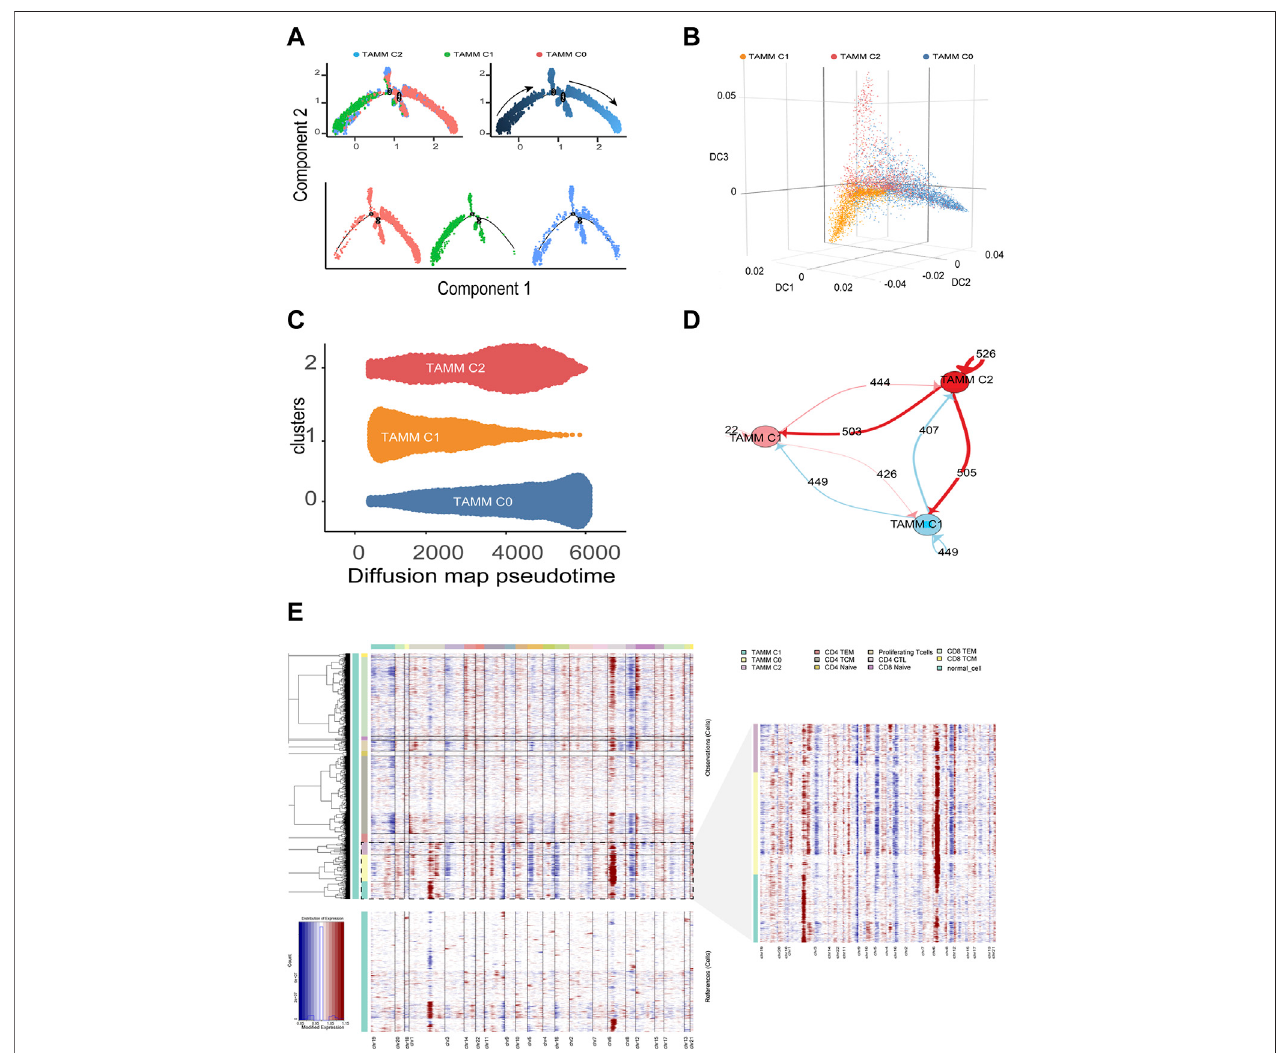
FIGURE2| Differentiationtrajectoryand CNVchangesofTAMM. (A) Monocle2 revealsthedifferentiationtrajectoryofTAMM. (B) Three-dimensionaldiffusionmap embedding of macrophages reveals the different differentiation states of TAMM sub-clusters. (C) Density diffusion maps model revealed the content of sub-clusters of TAMM at pseudo-time. (D) Cell-Cell interaction network of different TAMM sub-clusters, node represent TAMM sub-cluster, and the number of lines represent ligand interactions between two sub-clusters. (E) Heatmap of the inferred CNV in which genes were sorted by genomic location.